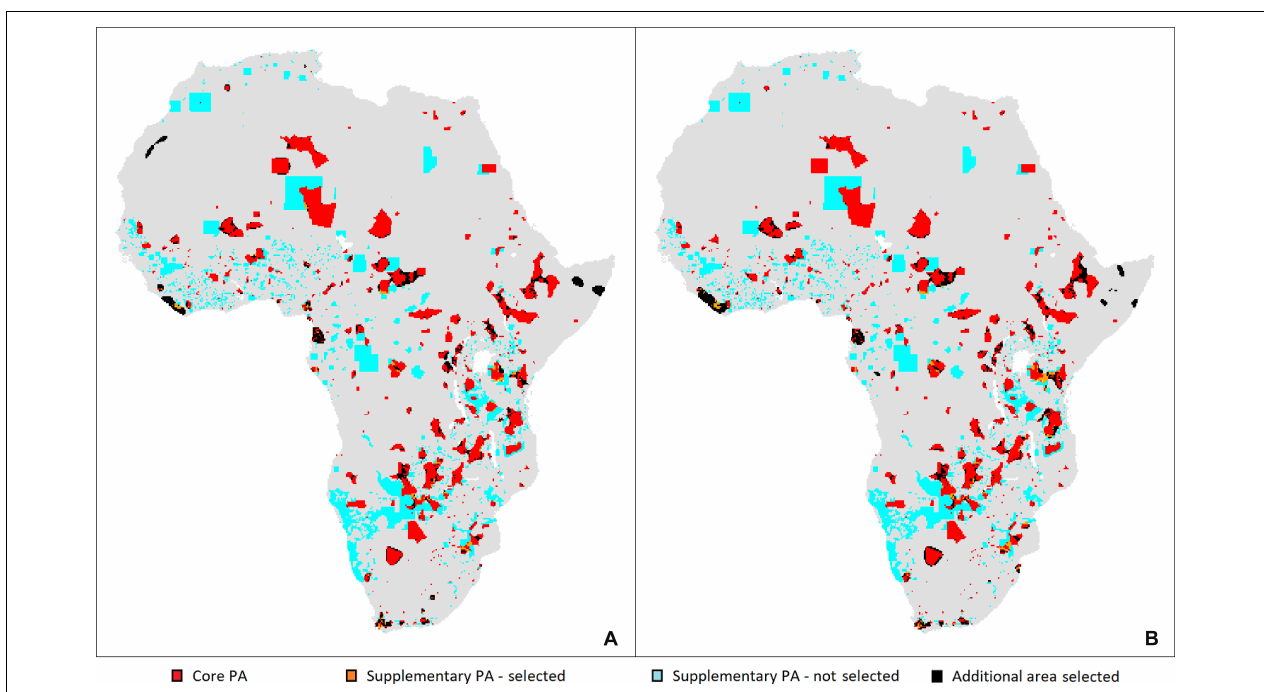
FIGURE 1 | Priority areas for antelope conservation in Africa under climate change. Gaps in the core protected area network identified by Marxan are shown in relation to current protection, where “selected” refers to Marxan priority areas. (A) Solution under the bioclimatic envelope approach. (B) Solution under the conservative approach where species are unable to